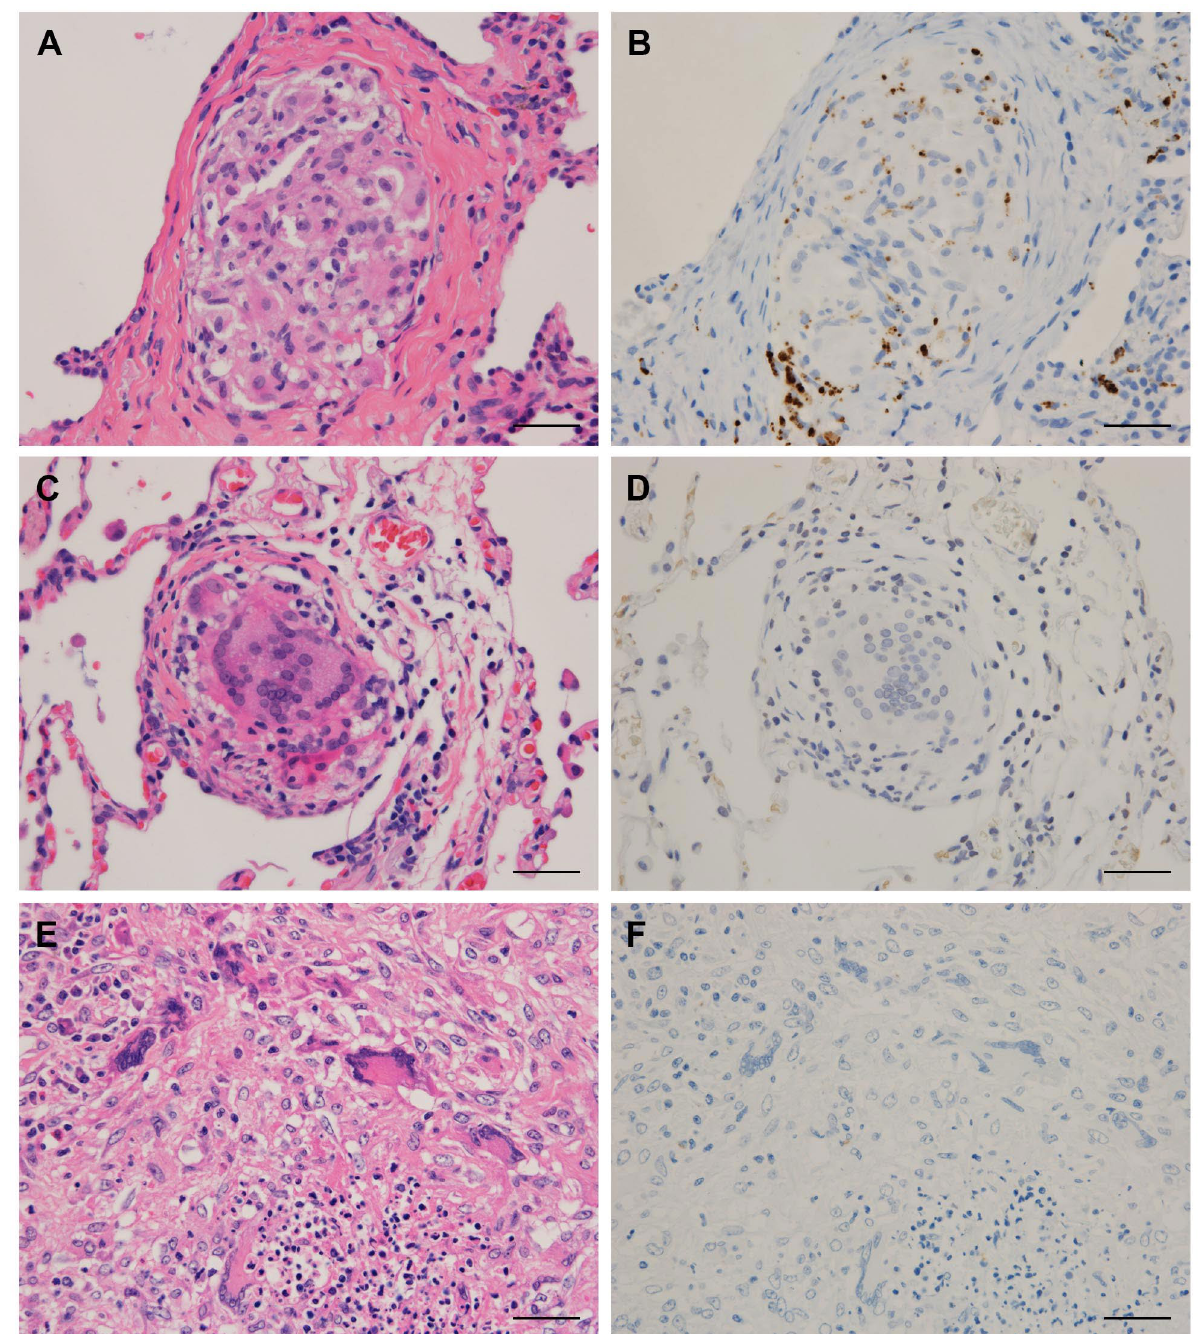
Figure 1. P. acnes detected in granulomas of the lungs from patients with sarcoidosis, hypersensitivity pneumonia, or granulomatosis with polyangiitis. Hematoxylin–eosin staining and immunohistochemistry with P. acnes -specific monoclonal antibody (PAB) are shown pairwise. PAB-reactive P. acnes (resulting in brown color) is observed in a solitary non-caseating epithelioid cell granuloma found in a TBLB sample of sarcoidosis ( A , B ). No signal of PAB-reactivity is observed in a small alveolar granuloma found in a VATS sample of hypersensitivity pneumonia ( C , D ) and in granulomatous inflammation found in a VATS sample of granulomatosis with polyangiitis ( E , F ). Scale bar: 50 μm.